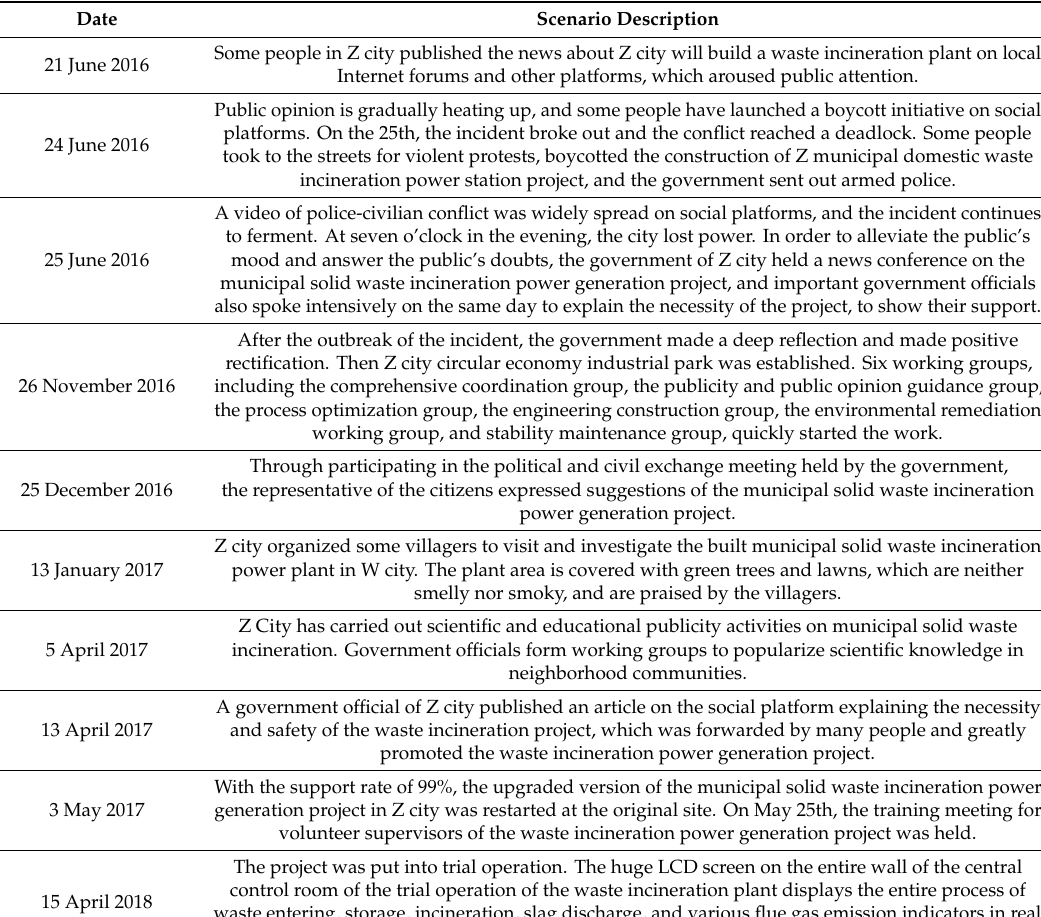
Table A1. Case Scenario Description in Time